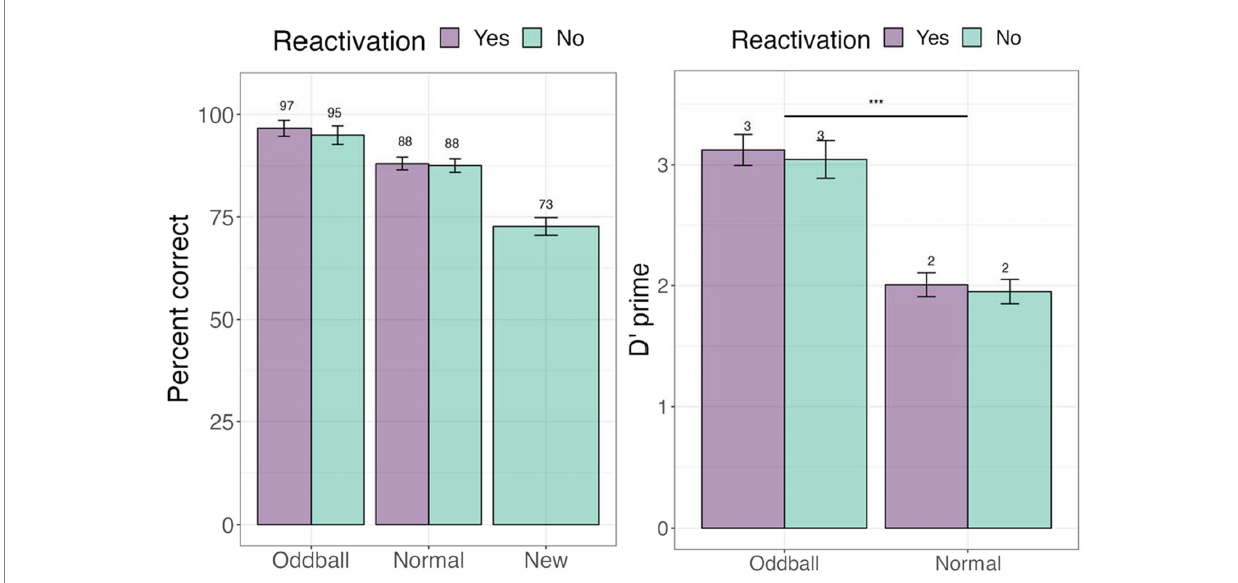
FIGURE 3 Percent correct and d’-prime values for the visual recognition test in Experiment 1. ***The significance of 0 < 0.001. Error bars represent standard errors of the